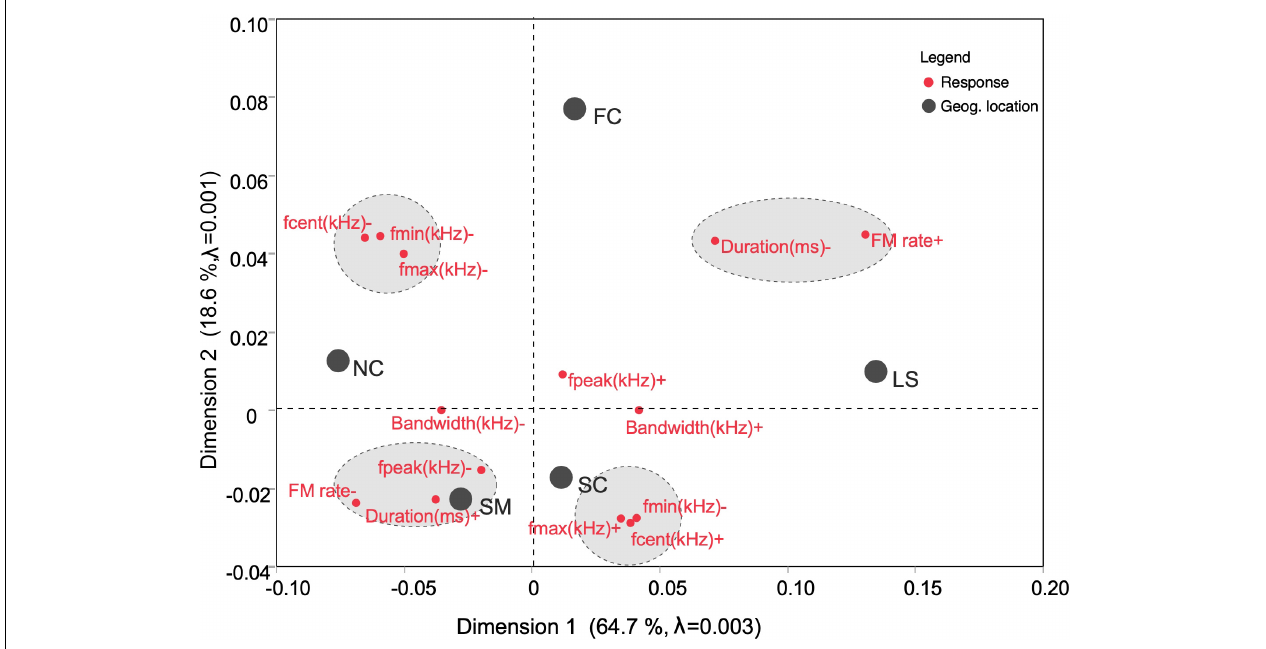
FIGURE 5 | A symmetric, two-dimensional multiple correspondence plot mixing observations (parametric values) with variables (geographic regions) to explain the acoustic basis of regional proximity. The five geographic regions are well separated into four quadrants of the plot contingent upon the values of the acoustic parameters placed in the same quadrant. Proximity of parameters and geographic locations are governed by the inertia determined by the commonality of the values or rankings for each level of a variable. Proximity of acoustic variables is highlighted gray ellipses enclosing red dots with corresponding parameters labeled. Negative values of a parameter indicate lower than expected proportion of contribution of that